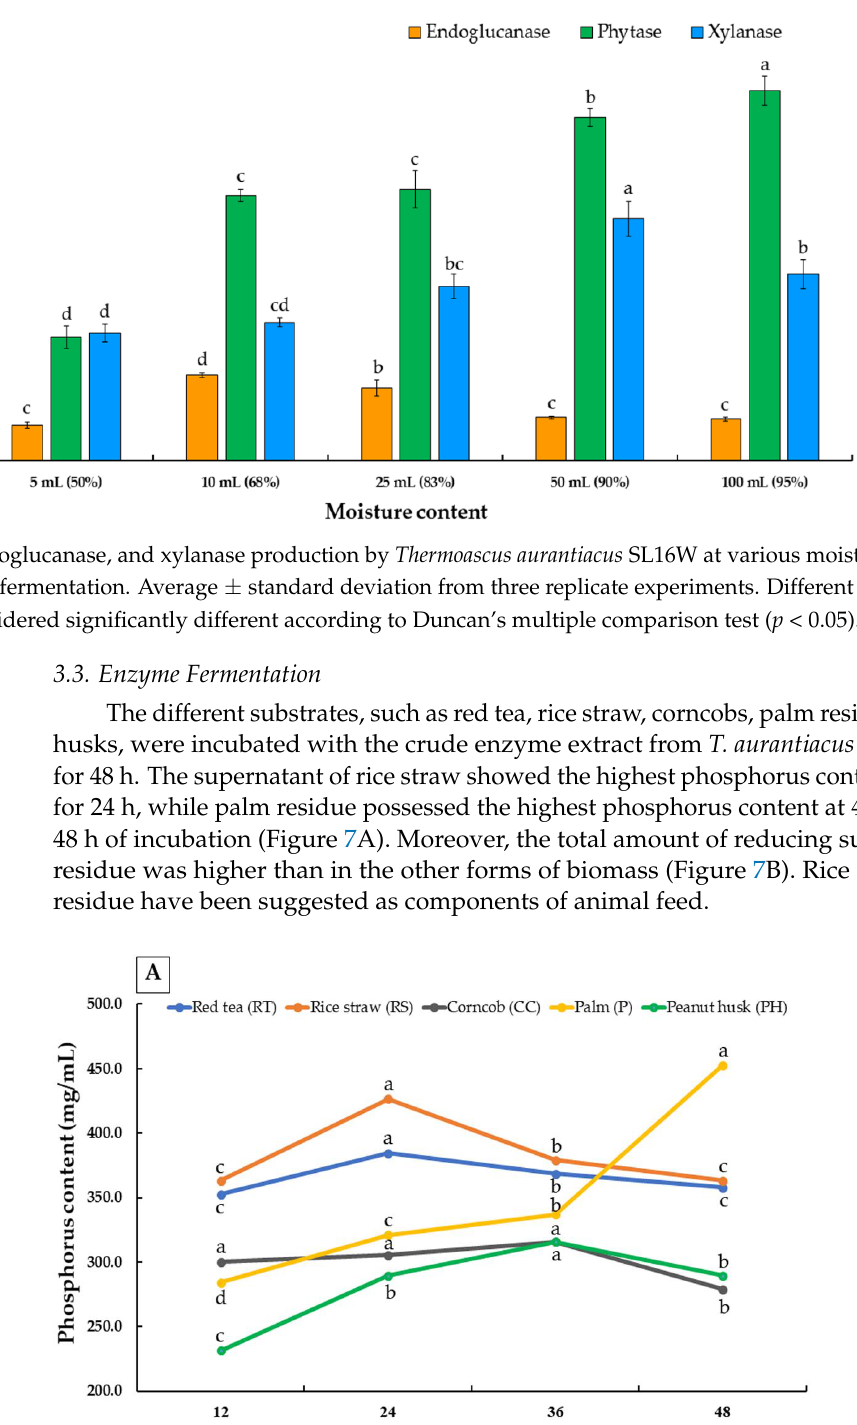
Figure 7 . Phosphorus ( A ) and total reducing sugar ( B ) content of crude enzyme extract obtained from Thermoascus auranti- acus SL16W using different substrates: red tea, rice straw, corncob, palm residue, and peanut husk. Different letters in the same column are considered significantly different according to Duncan’s multiple comparison test ( p ˂ 0.05).